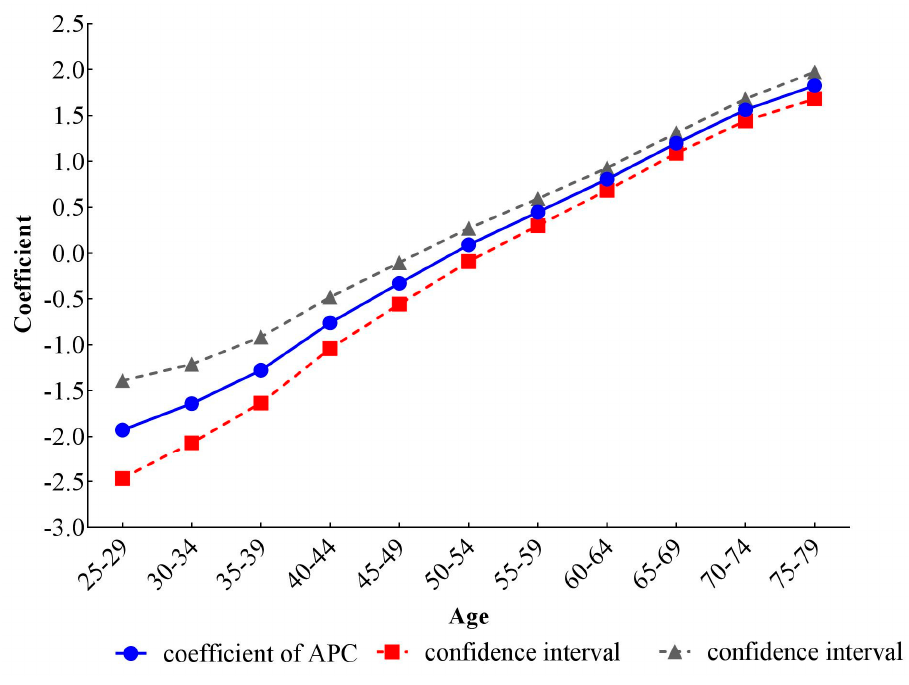
Figure 5. Age effects on stroke mortality PM 2.5 in China.